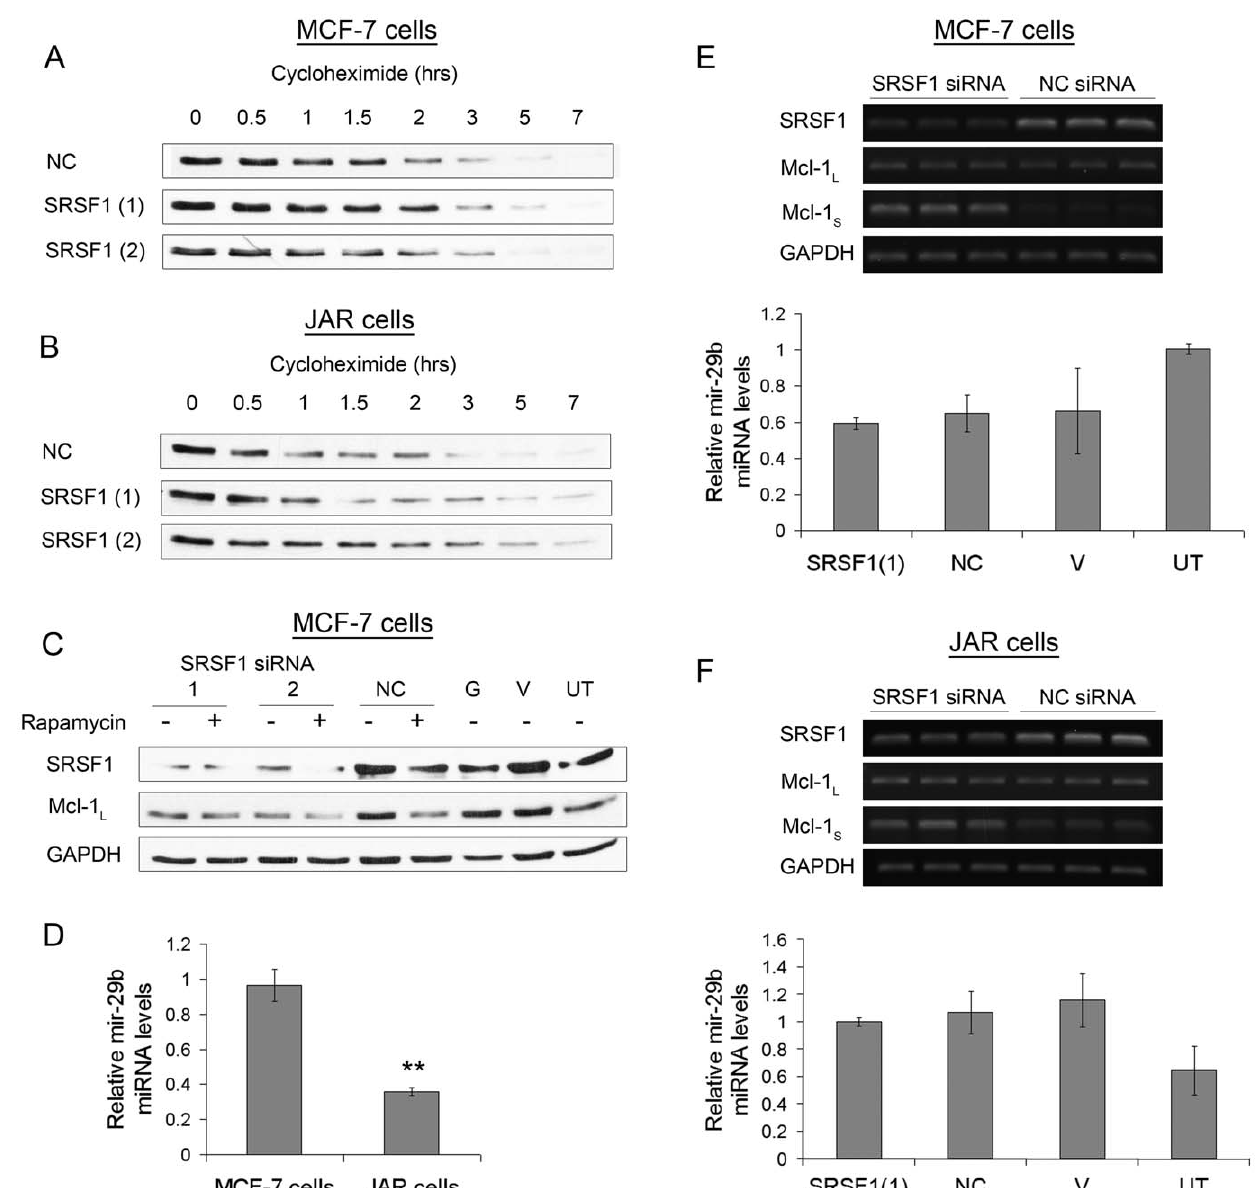
Figure 6. Effect of SRSF1 knockdown on expression, stability and translation of Mcl-1 L in MCF-7 and JAR cells. ( A ) MCF-7 and ( B ) JAR cells were transfected with SRSF1 (1 and 2) and negative control (NC) siRNA. Three days after transfection cells were treated with 35 ug/ml cycloheximide and protein samples were collected after 0, 0.5, 1, 1.5, 2, 3, 5 and 7 hours to assess protein stability. Mcl-1 L protein levels were then measured by immunoblotting. ( C ) MCF-7 cells were transfected with SRSF1 (1 and 2), GAPDH (G) and negative control (NC) siRNA, or treated with vehicle (lipid) only (V), or were untreated (UT). 48 hours after transfection cells were treated with 20 nM rapamycin for a further 24 hours. Western blotting was then used to assess protein levels of SRSF1, Mcl-1 L and GAPDH. ( D ) mir-29b levels measured by real-time PCR in JAR and MCF-7 cell lines (mean (n=3) 6 SEM), ** P # 0.01. Knockdown of SRSF1 in MCF-7 cells ( E ) and JAR cells ( F ) was assessed by semi-quantitative RT-PCR in SRSF1 (1) and negative control (NC) siRNA (upper panels). Levels of mir-29b were measured by real-time PCR in SRSF1 (1) and negative control (NC) siRNA treated MCF-7 cells from (E) and JAR cells from (F) along with GAPDH (G) siRNA, vehicle (lipid) only (V), and untreated (UT) cells (lower panels) (mean (n=3) 6